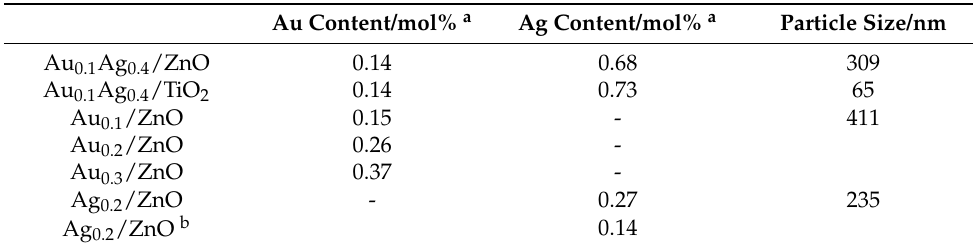
Figure 1. ( a ) Typical SEM_EDX image of Au 0.1 Ag 0.4 /ZnO; ( b ) XRD pattern of ZnO Au 0.1 Ag 0.4 /ZnO nanoparticle. Table 1. Summary of metal loadings on